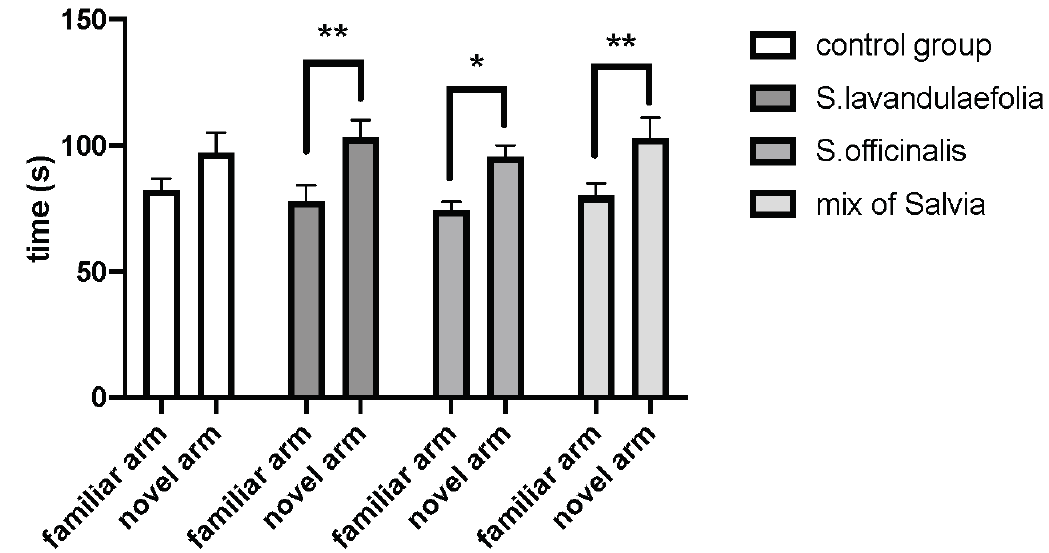
Figure 1. Acute Salvia supplementation restores short-term memory. Spatial memory performance was evaluated in the Y-maze test by measuring time spent exploring the novel and the familiar arms after a 1-hour retention intertrial interval (ITI). * p < 0.05, ** p < 0.01, for the familiar arm compared to the novel arm. n =